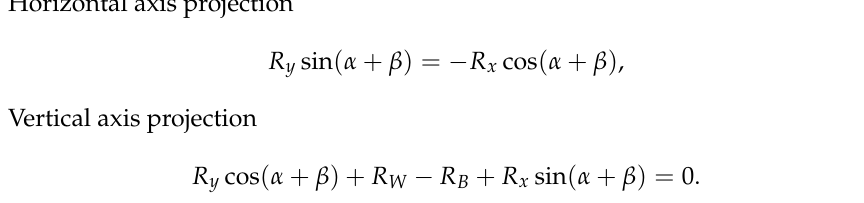
Figure 2. Steady descent of the underwater glider. Scheme of acting forces. Horizontal axis